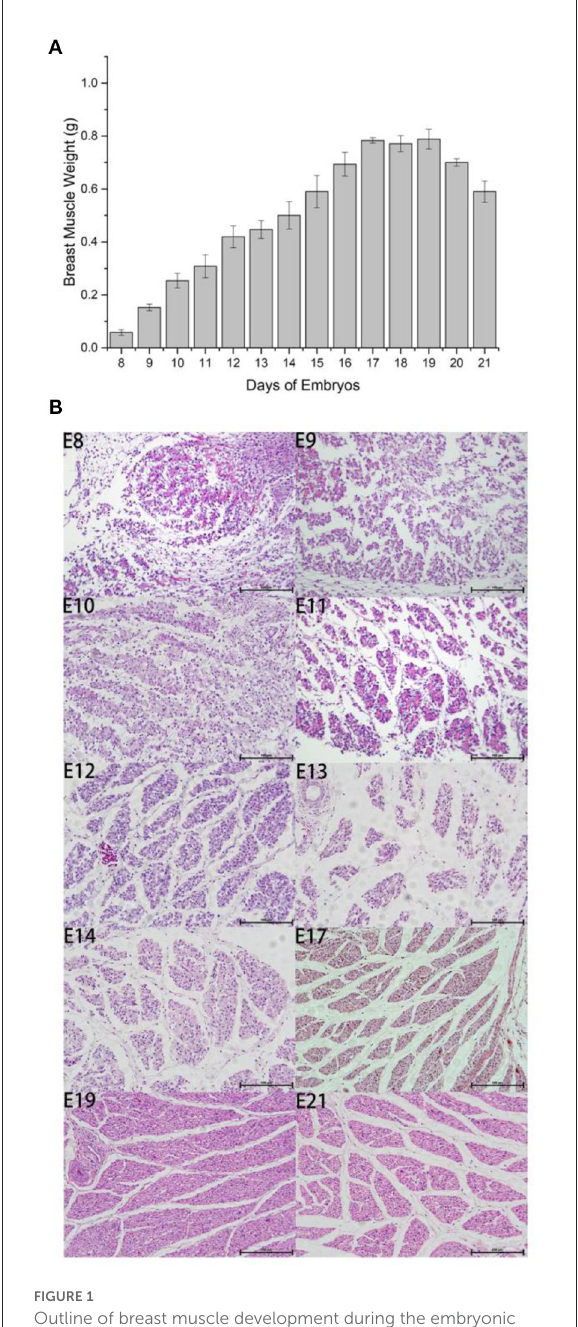
FIGURE1 Outline of breast muscle development during the embryonic stages of Wenchang chickens. (A) Trend of breast muscle weights. (B) Embryonic breast muscle slices of Wenchang chickens. 8–14, 17, 19, and 21 represented to embryonic 8 th day E8–E14, E17, E19, and E21,